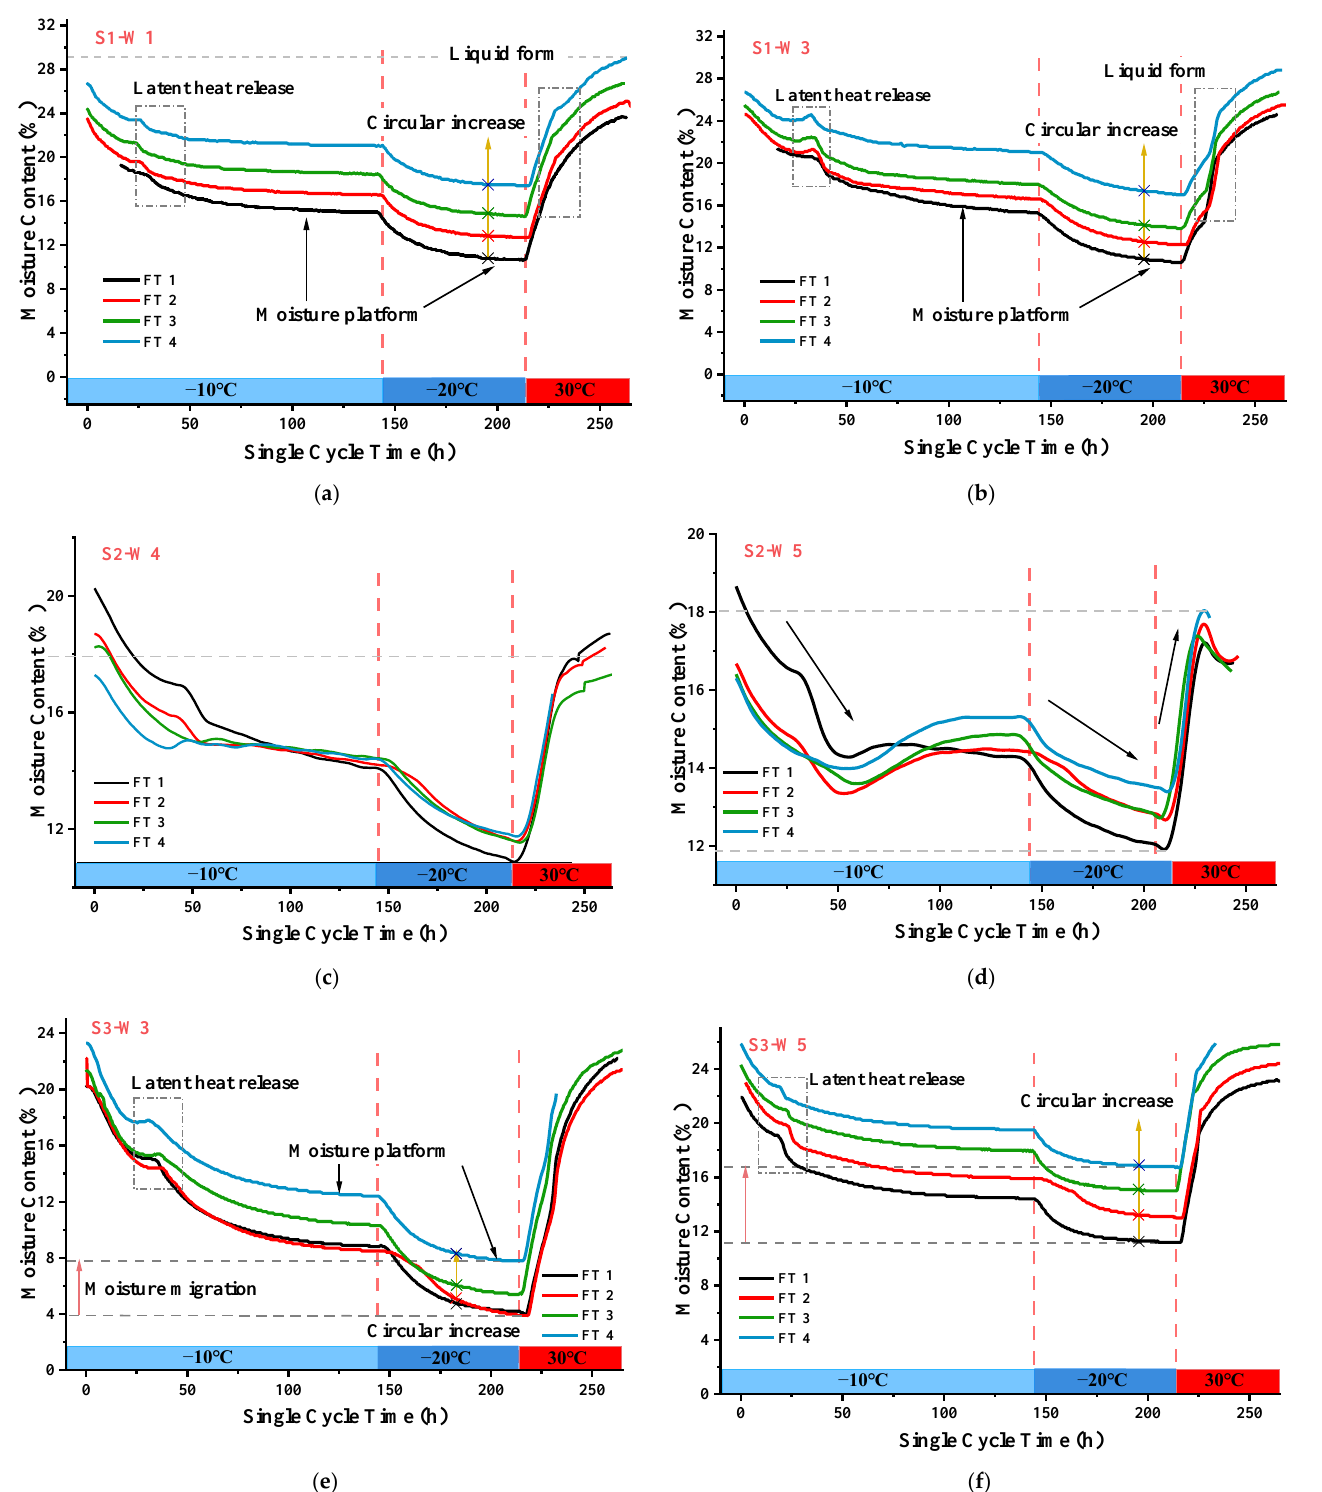
Figure 8. Moisture content of the slope model after four freeze – thaw cycles. ( a ) S1-W1; ( b ) S1-W3; ( c ) S2-W4; ( d ) S2-W5; ( e ) S3-W3; ( f ) S3-W5.